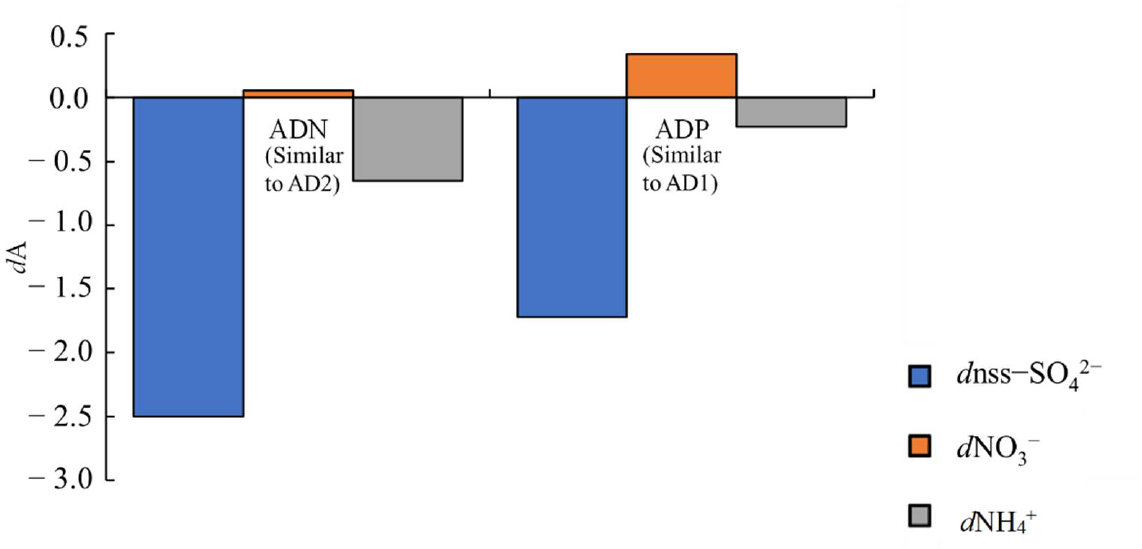
Figure 7. Secondary formation of nss-SO 42− , NO 3− and NH 4+ during ADP and ADN during the long-term observation from 2010 to 2015. ADN can be regarded as similar to the situation of the AD2 event, ADP can be regard as similar to the situation of AD1.